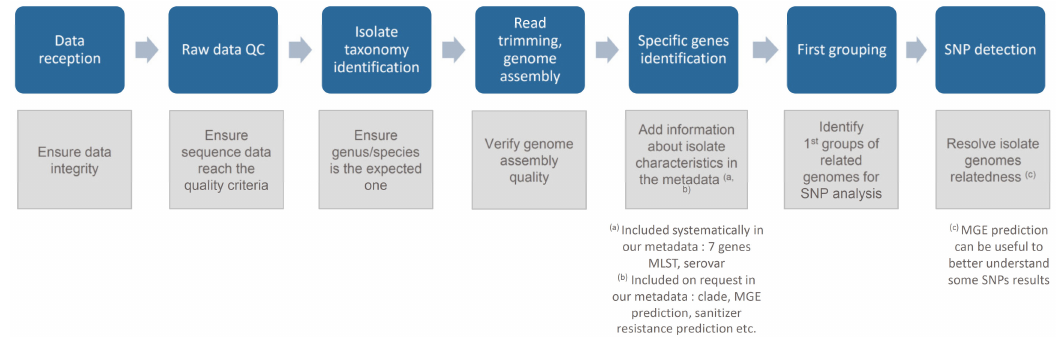
Figure 1. Key components of our pathogen source tracking whole genome sequencing (WGS) workflow: Overview and main goal of each